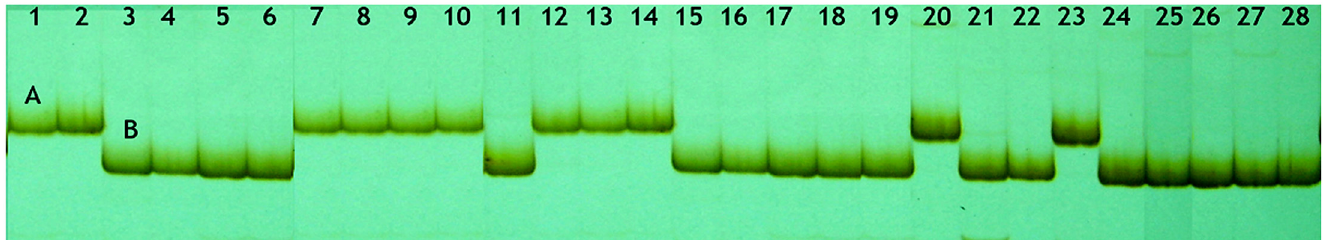
Fig 1. Allelic variation of TaCKX6a02 in the RIL population of Jing 411/Hongmangchun 21. Lane Nos. (1) Jing 411; (2) JH1; (3) Hongmangchun 21; (4) JH19; (5) JH31; (6) JH38; (7) JH2; (8) JH3; (9) JH4; (10) JH5; (11) JH73; (12) JH9; (13) JH10; (14) JH12; (15) JH75; (16) JH79; (17) JH81; (18) JH103; (19) JH105; (20) JH13; (21) JH107; (22) JH113; (23) JH15; (24) JH118; (25) JH120; (26) JH125; (27) JH129; and (28) JH130. In the figure, JH1, JH19, JH31, JH38, etc., represent individual names of the RIL population. Two types of alleles, TaCKX6a02-D1a (Jing 411) and TaCKX6a02-D1b (Hongmangchun 21) are marked with the letters “ A ” and “ B ” ,